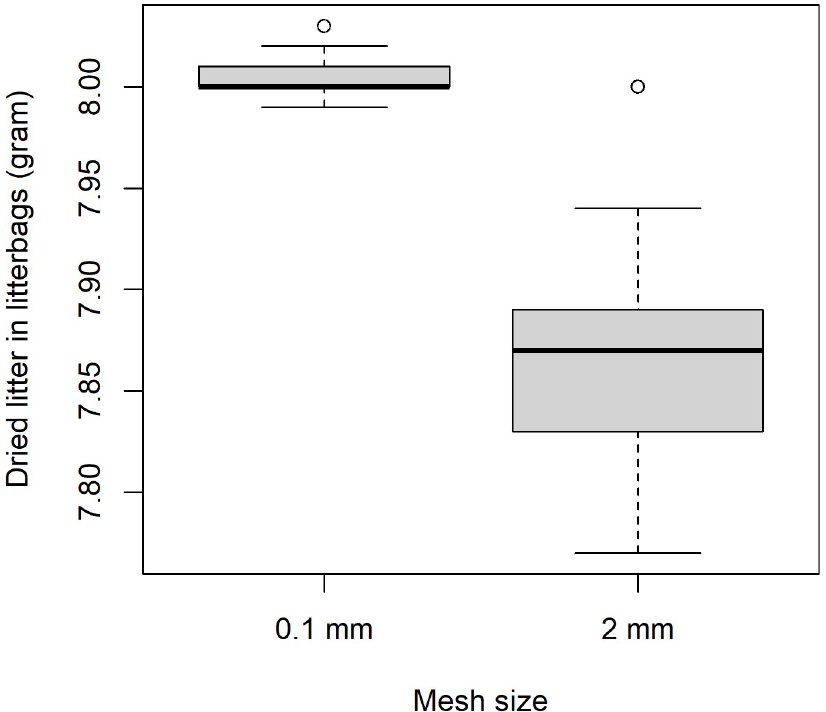
Fig 2. Boxplot of amount of dried litter filled in fine-meshed and coarser-meshed litterbags before one deployment.